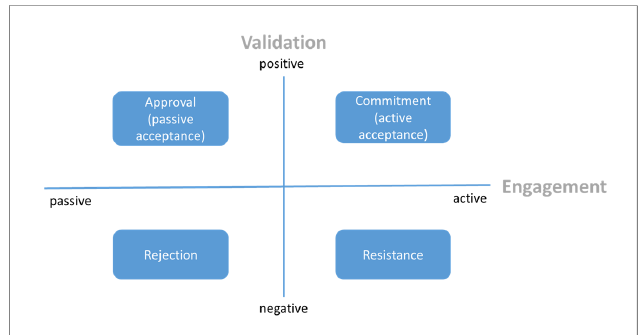
Figure 1. Dimensions of acceptance, translated and adapted from [24,26].